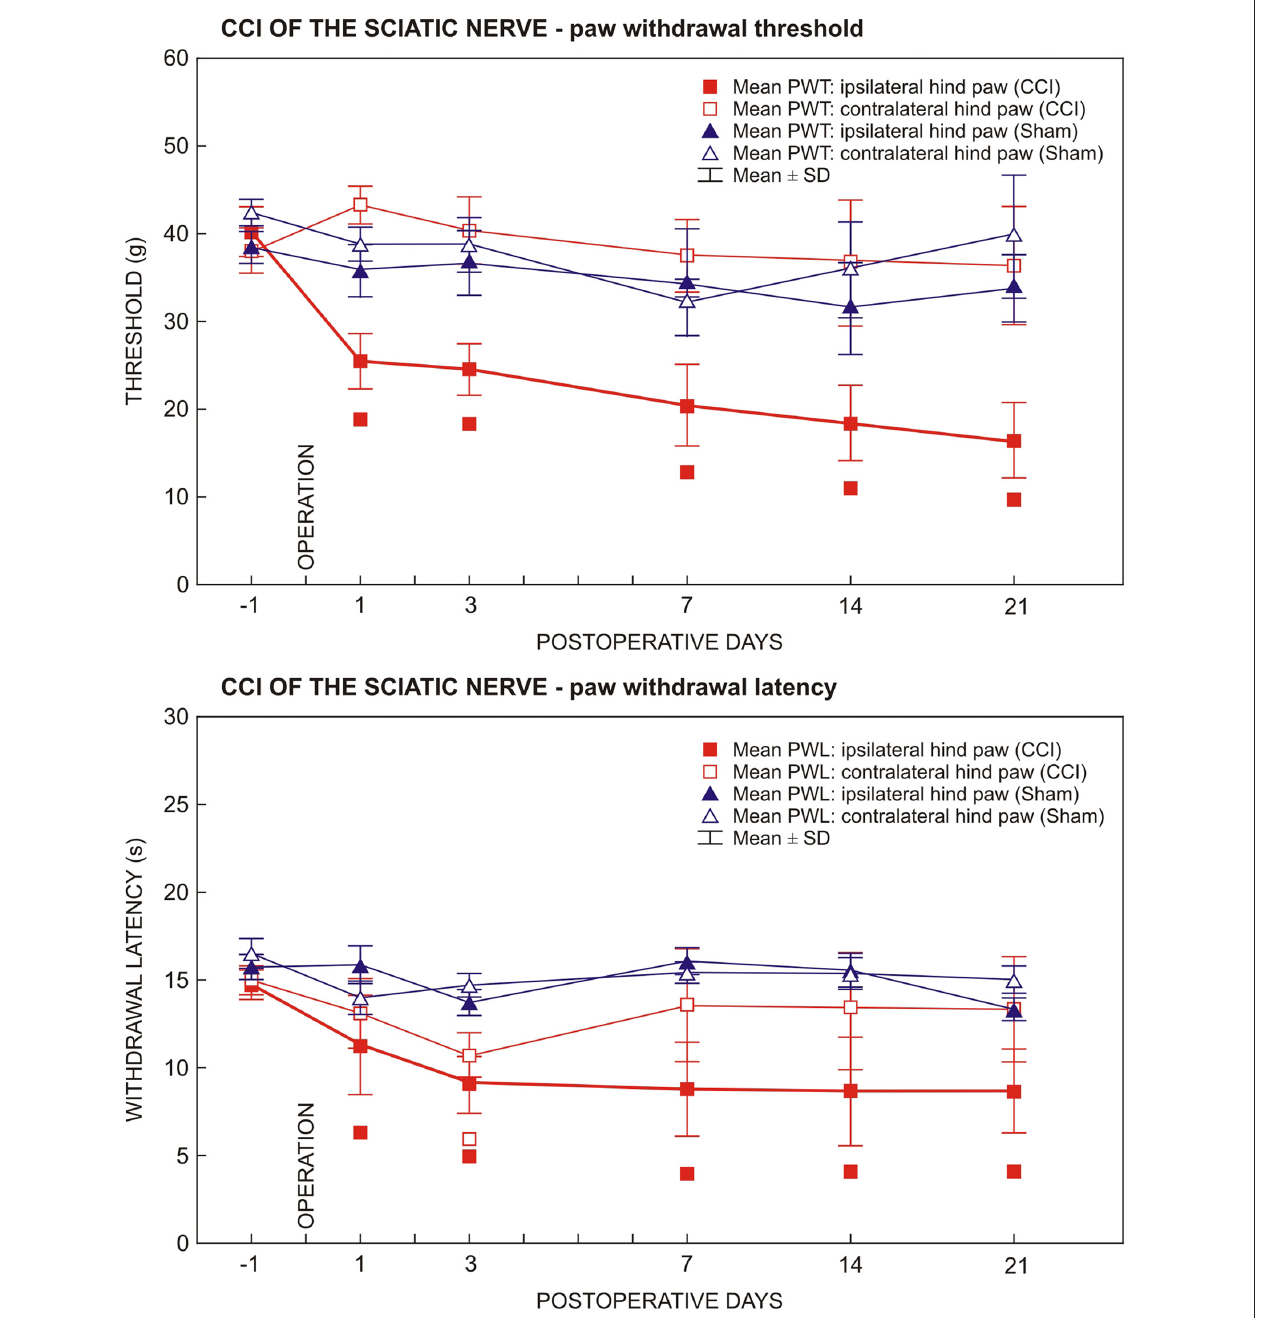
FIGURE 1 | Results of behavioral tests in rats operated upon to create unilateral sterile chronic compression injury (sCCI) of the sciatic nerve and sham-operated rats. Development and maintenance of paw withdrawal threshold (PWT) and paw withdrawal latency (PWL) was measured in the ipsilateral hind paws of sCCI-operated rats indicating mechanical allodynia and thermal hyperalgesia, respectively. Transient thermal hyperalgesia was measured bilaterally 3 days following sCCI. Data are expressed as mean ± SD of PWT in grams and PWL in seconds for mechanical allodynia and thermal hyperalgesia, respectively. Symbols below the curves indicate a statistically significant difference ( p < 0.05) compared to sham-operated rats.